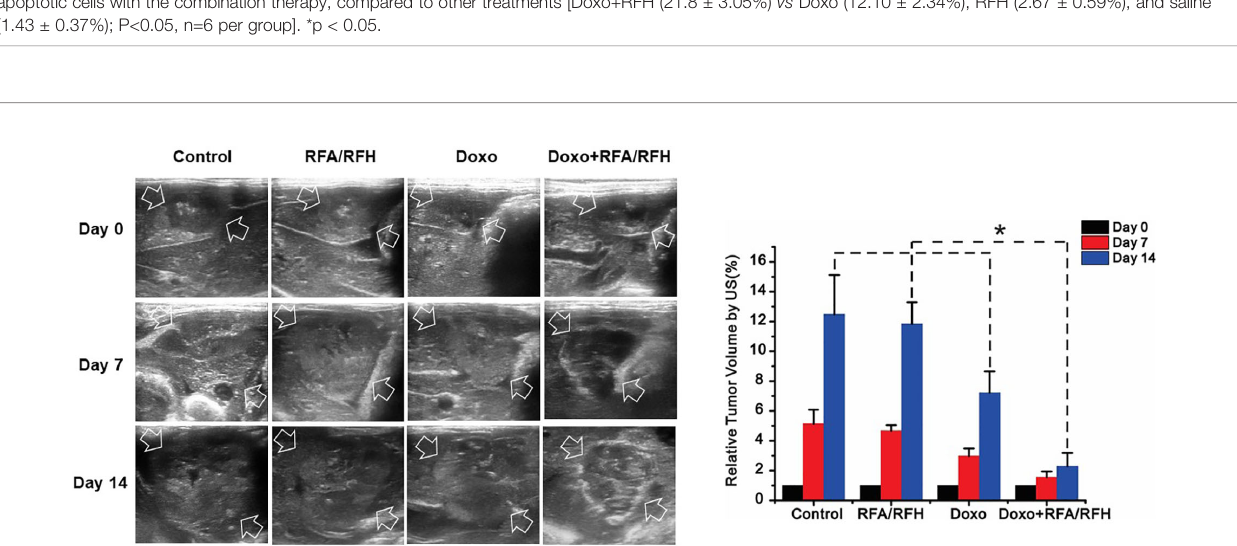
FIGURE 5 | In vivo studies using rabbit models with orthotopic liver VX2 tumors in four groups with different treatments to validate the feasibility of this new interventional oncologic technique. (Left) Ultrasound imaging demonstrates a signi fi cant decrease of tumor growth rate at day 14 post-treatment with RFH-enhanced therapy, compared to the other three control treatments [Doxo+RFA/RFH (2.29 ± 0.9) vs Doxo (7.23 ± 1.43), RFA/RFH (11.84 ± 1.45), and saline (12.48 ± 2.64); P<0.05, n=6 per group, Right]. *P <